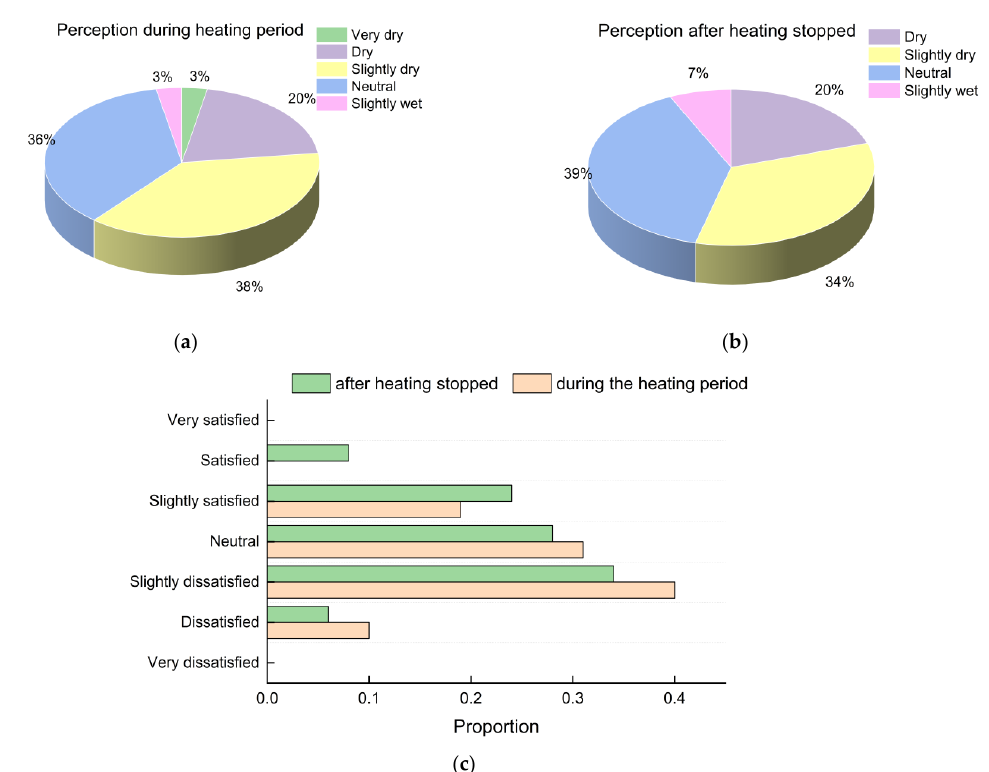
Figure 6. Subjective evaluation of RH: ( a ) perception during the heating period; ( b ) perception after heating stopped; ( c ) satisfaction proportions.